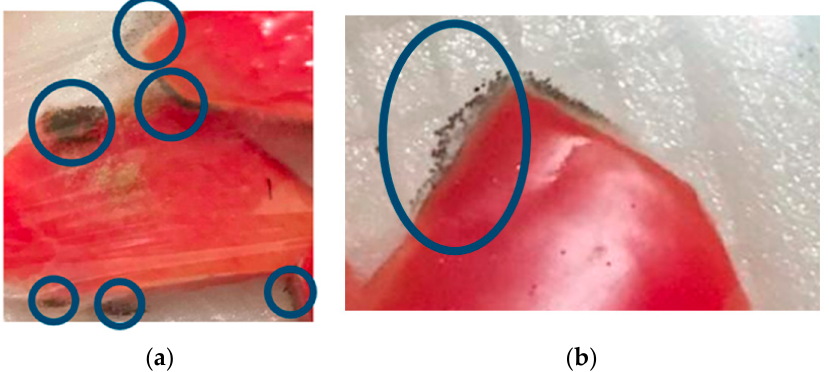
Figure 10. Fungal decay on the 2nd day of storage at room temperature. (±25 °C) ( a ) and the 15th day of storage at low temperature (±4 °C) ( b ).